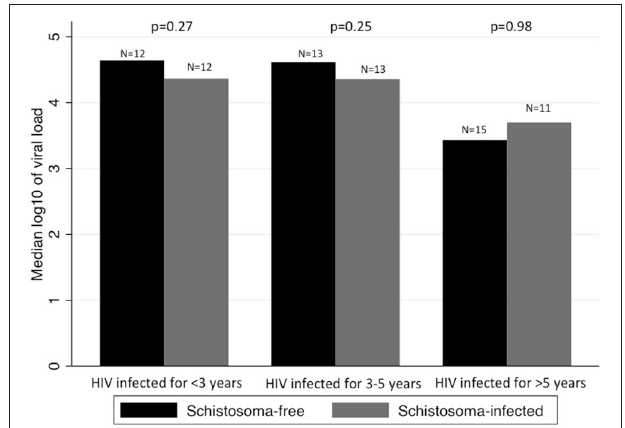
FIGURE 2 | Comparison between median viral loads by time infected with HIV-1 and by Schistosoma -infection status. Panel shows the median log 10 of viral load in Schistosoma -free and Schistosoma -infected patients, by category of duration of HIV-1 infection. The difference in median log 10 of viral load was assessed by rank-sum test. There was no difference in median log 10 of viral load between Schistosoma -free and Schistosoma -infected, regardless of the duration of HIV-1